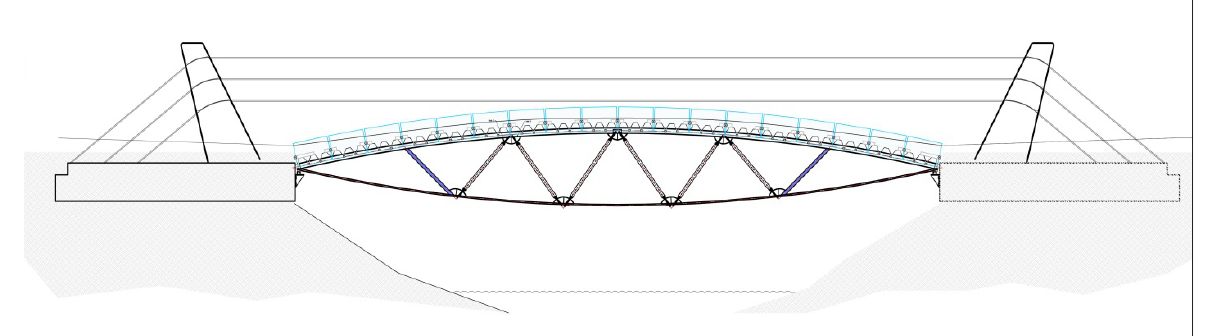
Fig. 7 steel pre-tension rod and pla centering